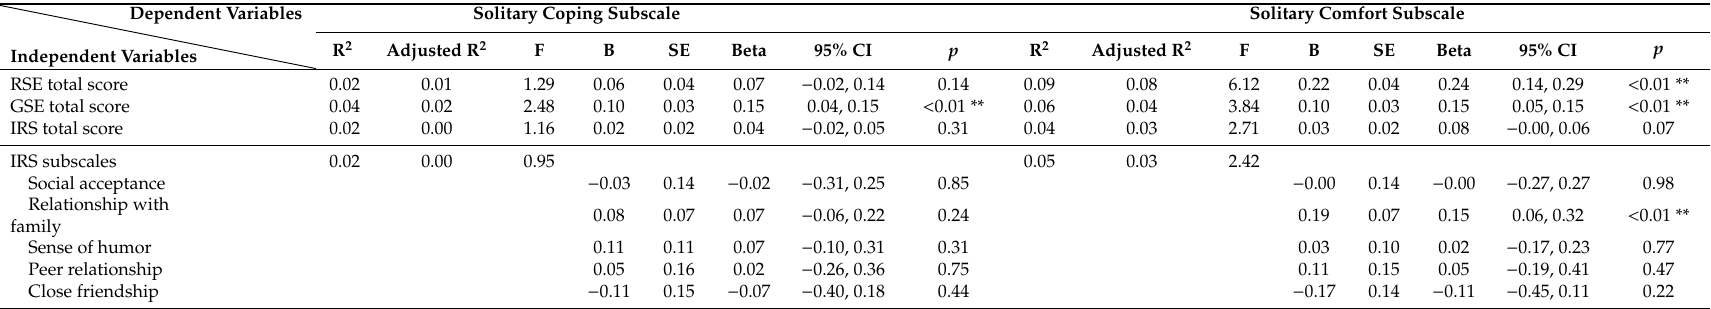
Table 4. Multiple regression analysis for identifying Solitude Capacity Scale † with two dimensions significantly related to Rosenberg Self-Esteem Scale, General Self-E ffi cacy Scale, and Interpersonal Relationship Scale for College Students with subscales. VariablesDependent Variables Solitary Coping Subscale Solitary Comfort Subscale Independent